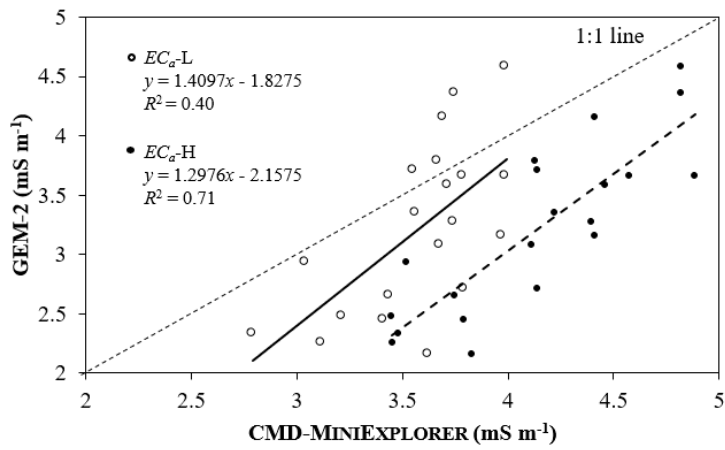
Figure 5. Scatter-plot of EC a measured using CMD-MINIEXPLORER and GEM-2.